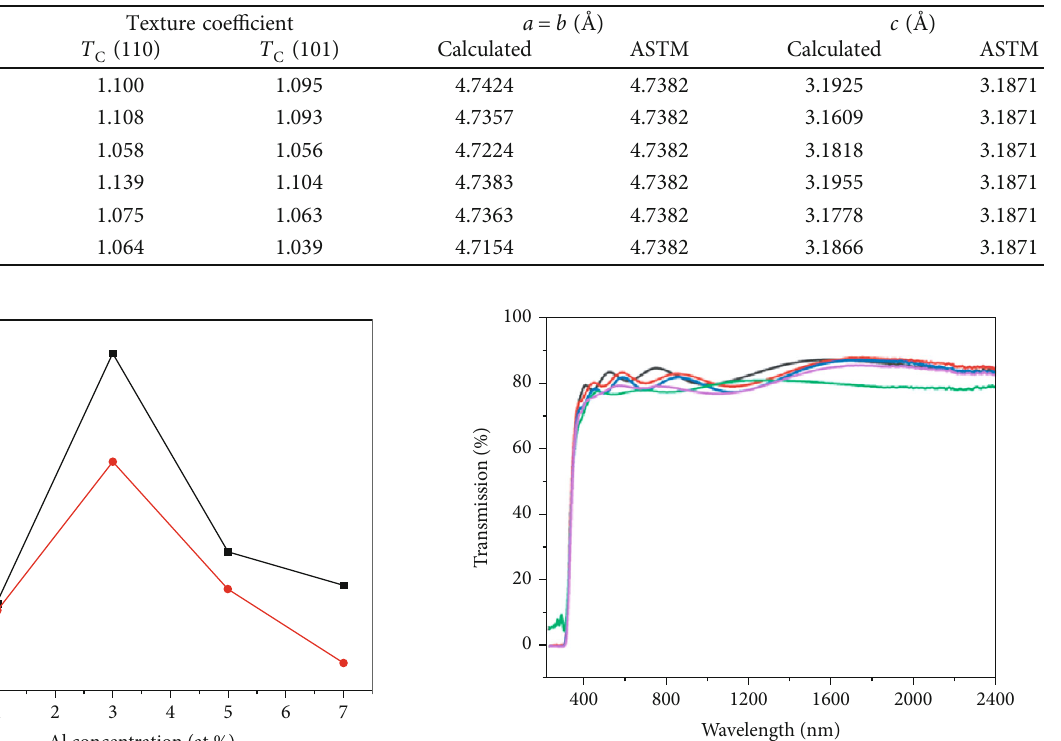
thin fi lms (ASTM of SnO 2